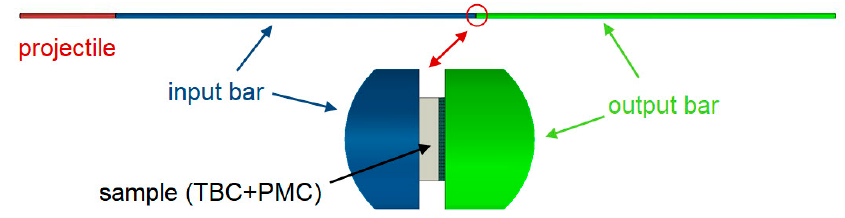
Figure 13. Scheme of sample mounting.